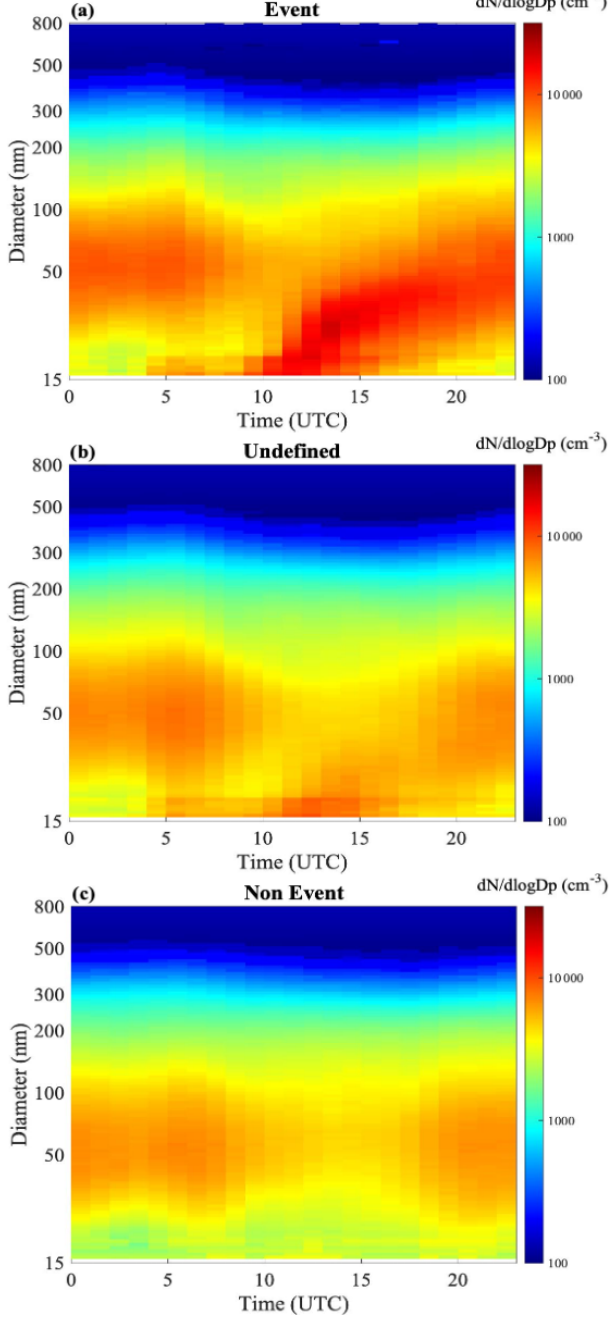
Figure 3. Hourly median particle number size distribution (15.7nm < D p < 800nm) observed during NPF event (a) , unde- fined (b) , and non-event (c) days in spring and summer from 2017 to 2020.